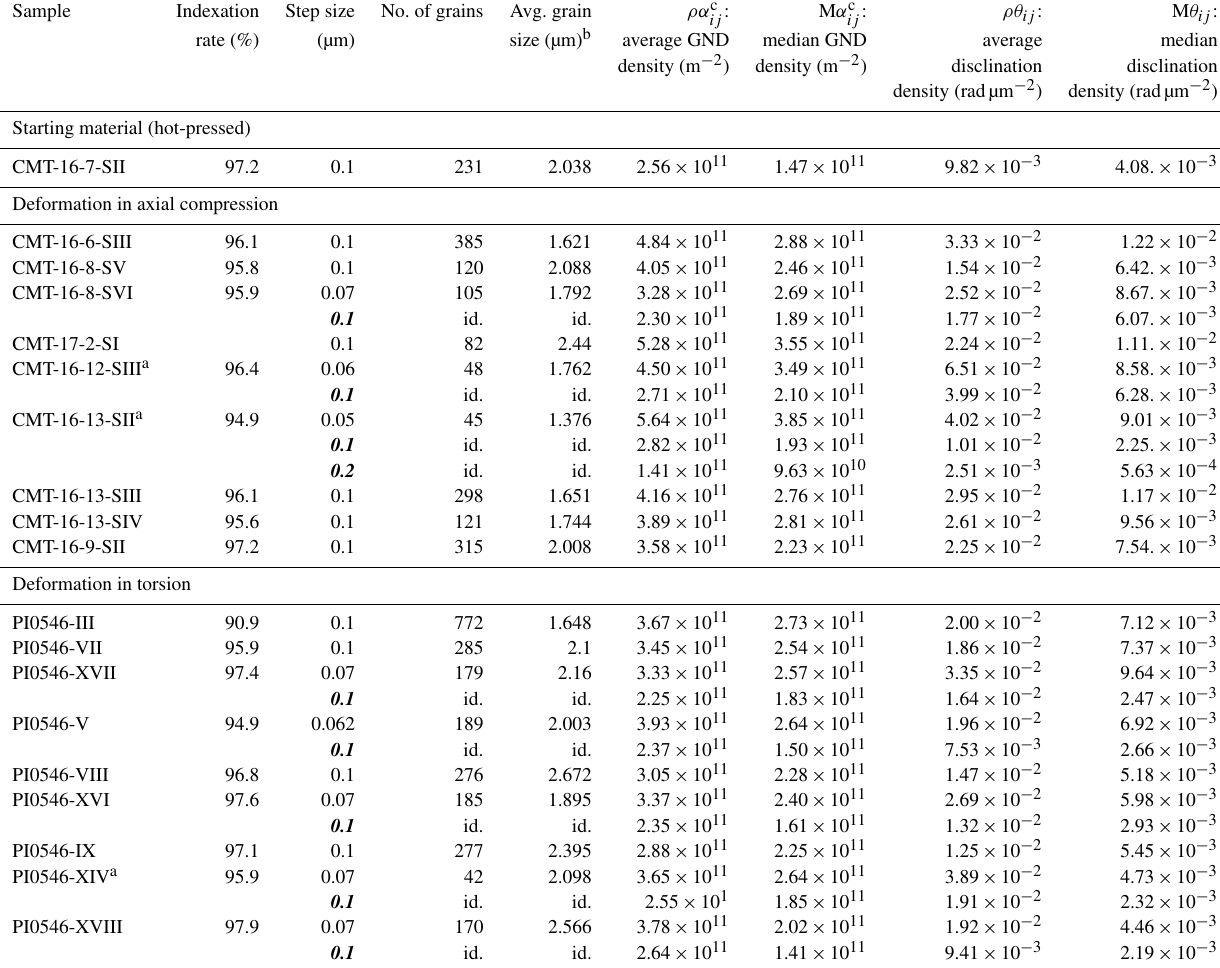
Table 2. For the studied EBSD maps, we report the indexation rate after data treatment, the original step size and subsequent re-step size (italicized and bold), the number of detected grains, the average grain size, and the calculated partial GND dislocation densities. We provide the average of grain density and the median grain density for α ij . The average of each α c and θ ij per grain is given in Table S1 in the ij Supplement. Roman numerals identify individual EBSD maps acquired for the same sample (“S” stands for small-area maps). Maps from samples deformed in torsion are taken at three different positions and hence with increasing strains. Idem number of grains: